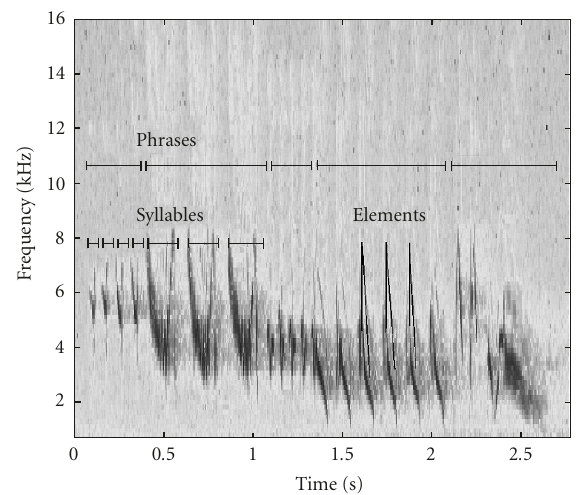
Figure 1: Hierarchical levels of song for the common cha ffi